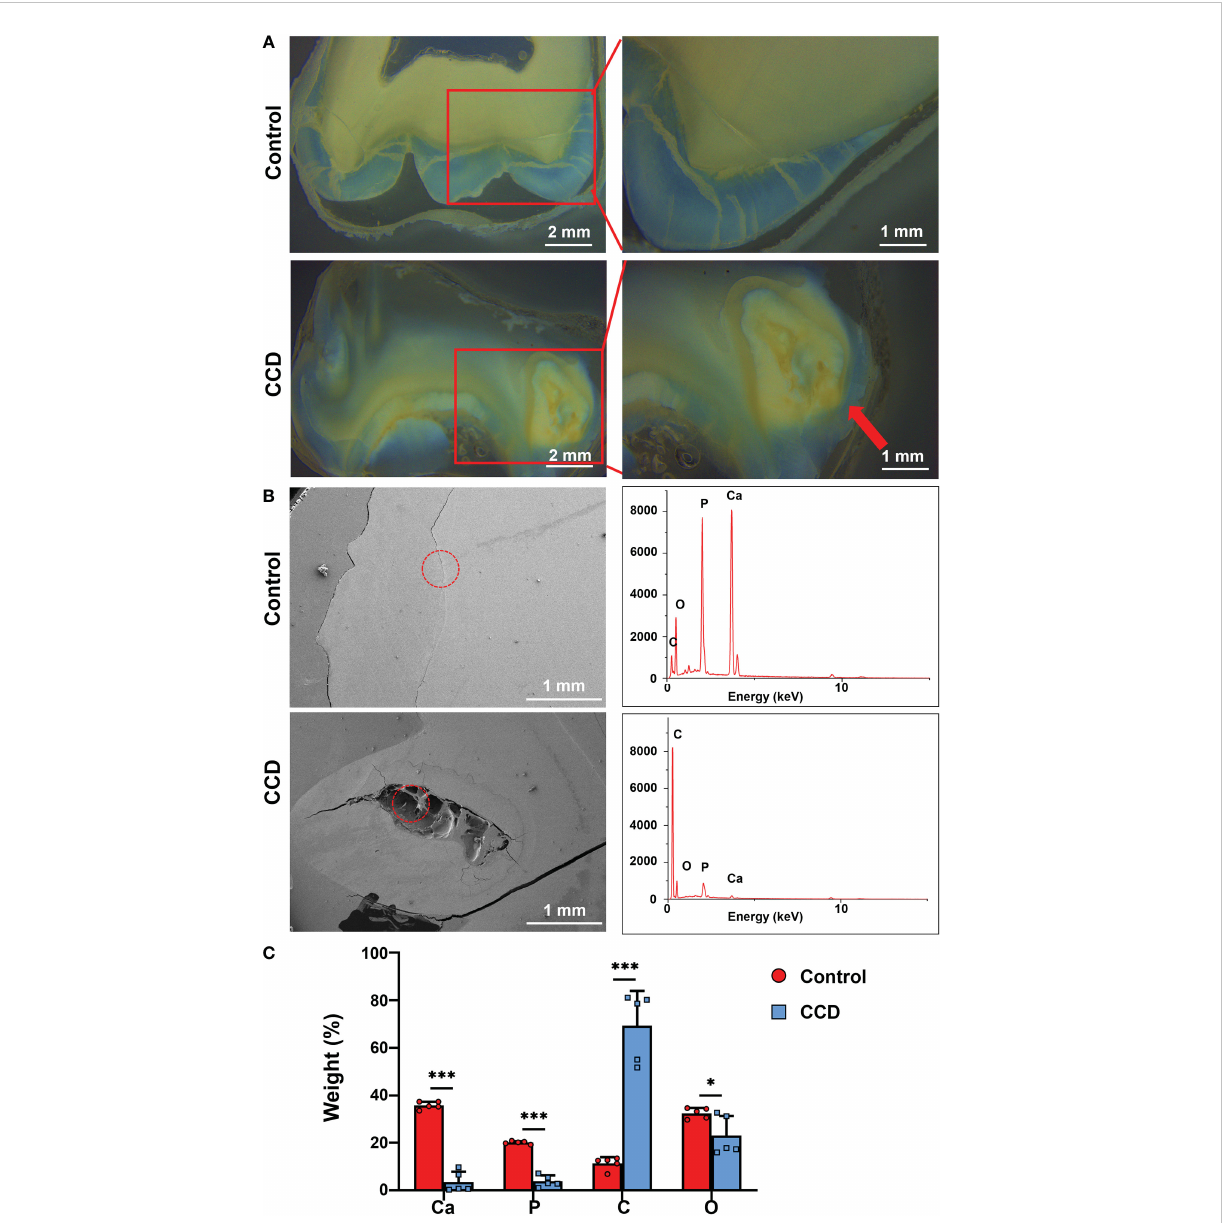
FIGURE 4 Dentinogenesis imperfecta of patients with CCD. (A) Stereo microscopy showing the morphology difference between the two groups. Red arrow indicates the disorganized structure of dentin. Scale bar: 2 mm, 1 mm. (B) SEM images and EDX spectra of the two groups. The red circle refers to the analyzed area of the EDX spectra. Scale bar, 1 mm. (C) Weight percentage of the elements of tooth slabs of the two groups (n = 5, *p < 0.05, ***p <